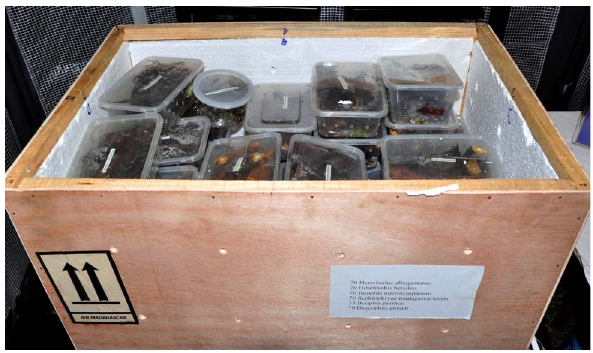
Figure 1. One of two crates of amphibians sampled for Batrachochytriumdendrobatidis upon arrival from Madagascar. Amphibians were shipped sealed in wooden crates, insulated with 1/4 0 Styrofoam, and packed in plastic containers filled with damp sphagnum moss and leaves.